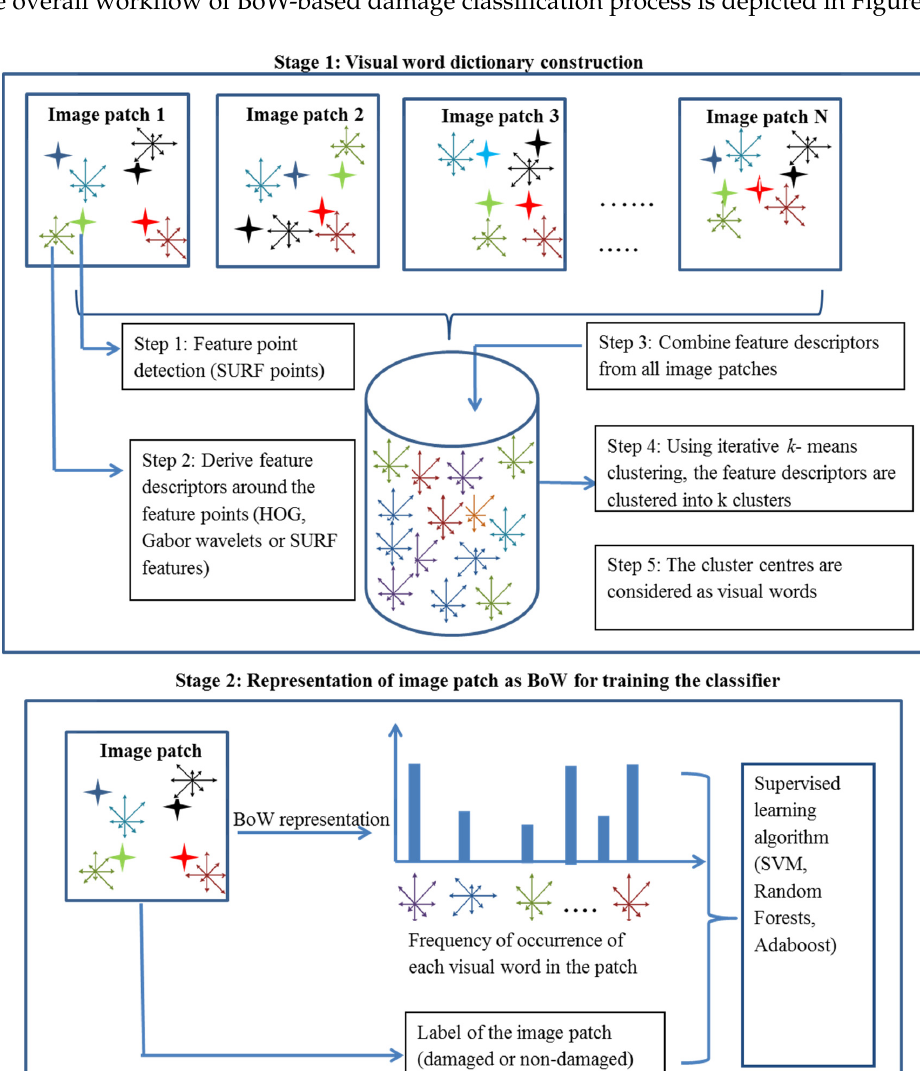
Figure 2. Overall process of the BoW-based damage classification.